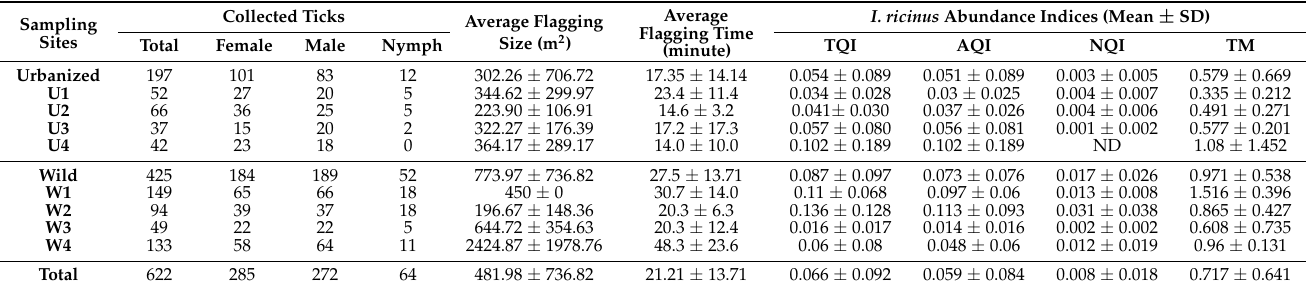
in U2, 37 in U3 and 42 in U4), 425 were collected from the wild area (149 in W1, 94 in W2, 49 in W3 and 133 in W4). All of the ticks were identified as Ixodes ricinus (of which 46% ( n = 285) were female, 44% male ( n = 272) and 10% ( n = 64) were nymphs). The data were obtained from a total of 42 tick collection campaigns performed 15 times in the wild and 27 times in urban areas. The overall mean indices calculated over five years of study for I. ricinus distribution is presented in Table 2. Table 2. The number of Ixodes ricinus ticks collected and the indices for total, adults, nymphs and ticks per minute in the urbanized and wild areas. The data presented are average values ± standard deviations (SD) for a five-year study period (2016–2020).